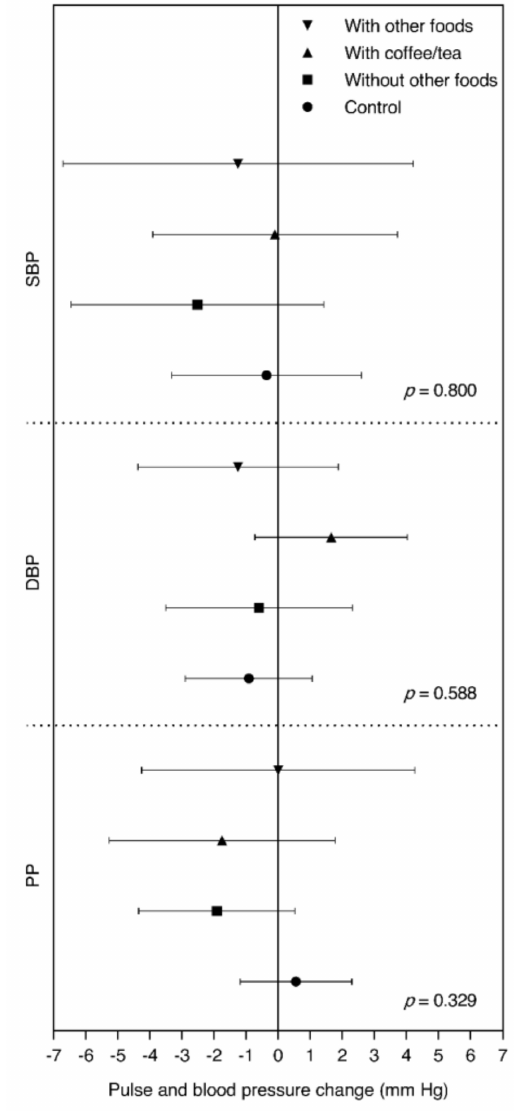
Figure 2. Changes in diastolic blood pressure (DBP), systolic blood pressure (SBP), and pulse pressure (PP) by the mode of chocolate intake in postmenopausal women participants. Values are di ff erences in means (95% CI). n = 14 in subgroup that consumed chocolate with other foods, n = 20 in subgroup that consumed chocolate with co ff ee / tea, n = 36 in subgroup that consumed chocolate without other foods, n = 66 in control group. p -values from ANOVA for di ff erences in DBP, SBP, and PP between all subgroups are